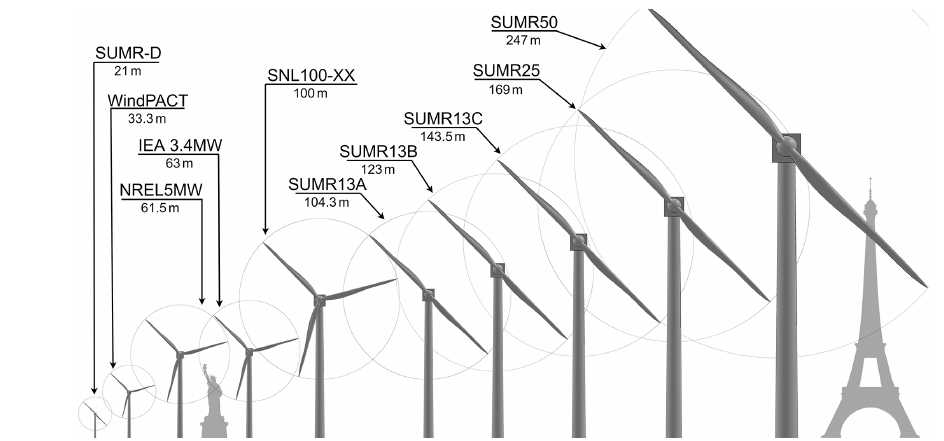
Figure 2. Illustration comparing the wind turbine models considered in this study of flutter behavior in two- and three-bladed rotors.